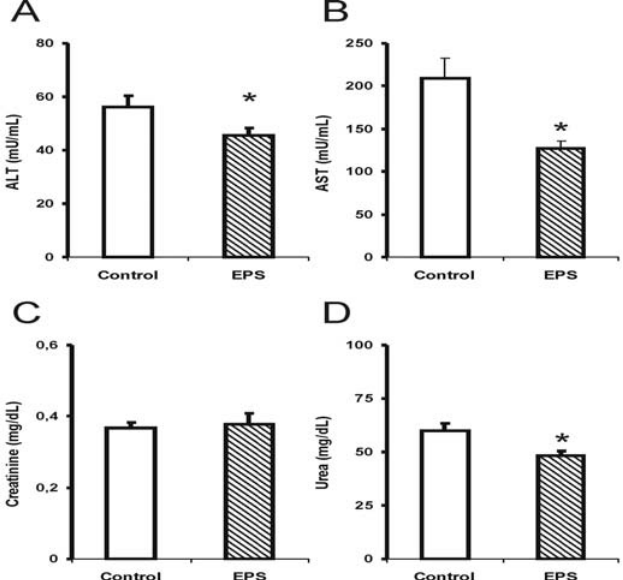
Figure 3. Hepatotoxicity markers in female mice submitted to sub-chronic treatment with lasiodiplodan. Specific transaminases ( A ) ALT and ( B ) AST; ( C ) creatinine, and urea ( D ). ( * ) Values based on p <